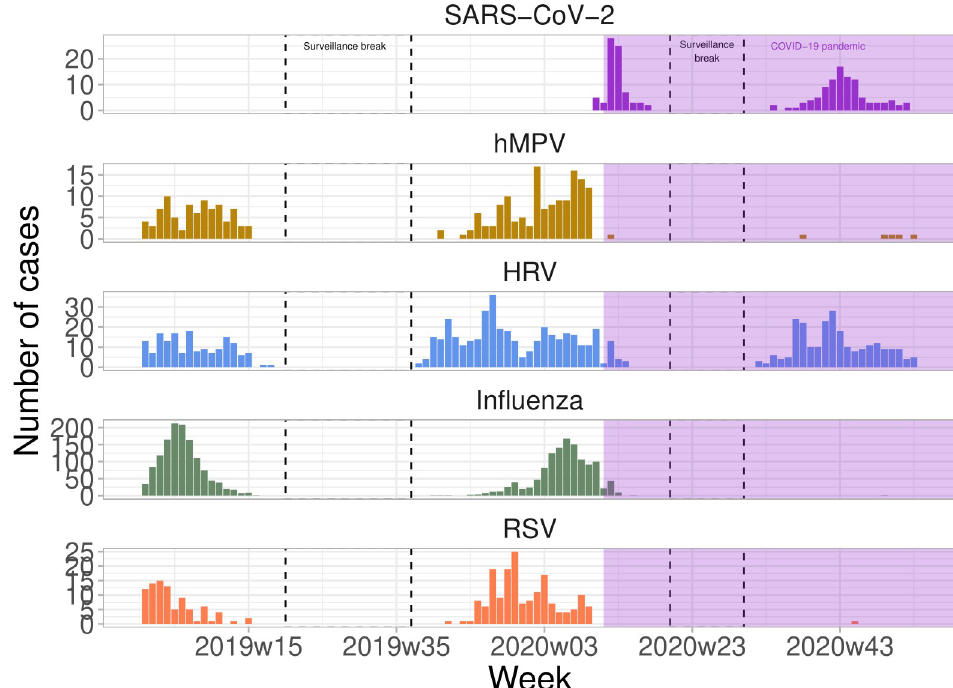
Fig 4. Number of viruses detected by virological confirmation in ARI consultation.